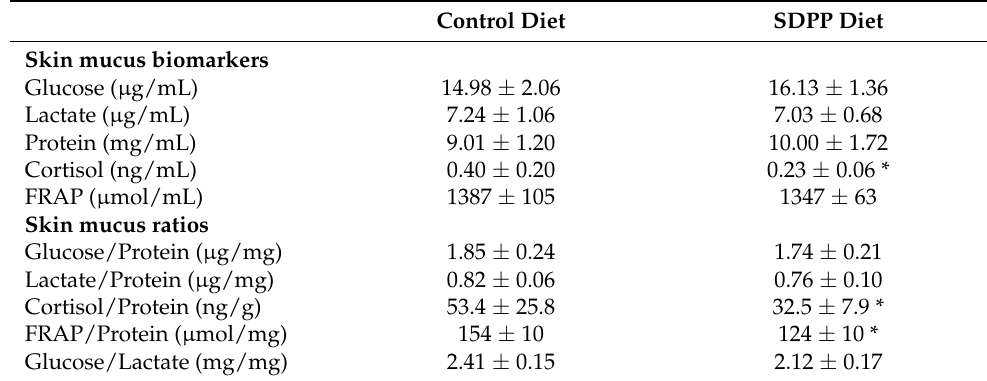
Table 3. Skin mucus biomarkers and their ratios from gilthead sea bream ( Sparus aurata ) juveniles fed low fishmeal diets containing 5% of spray-dried porcine plasma (SDPP). Control Diet SDPP Diet Skin mucus